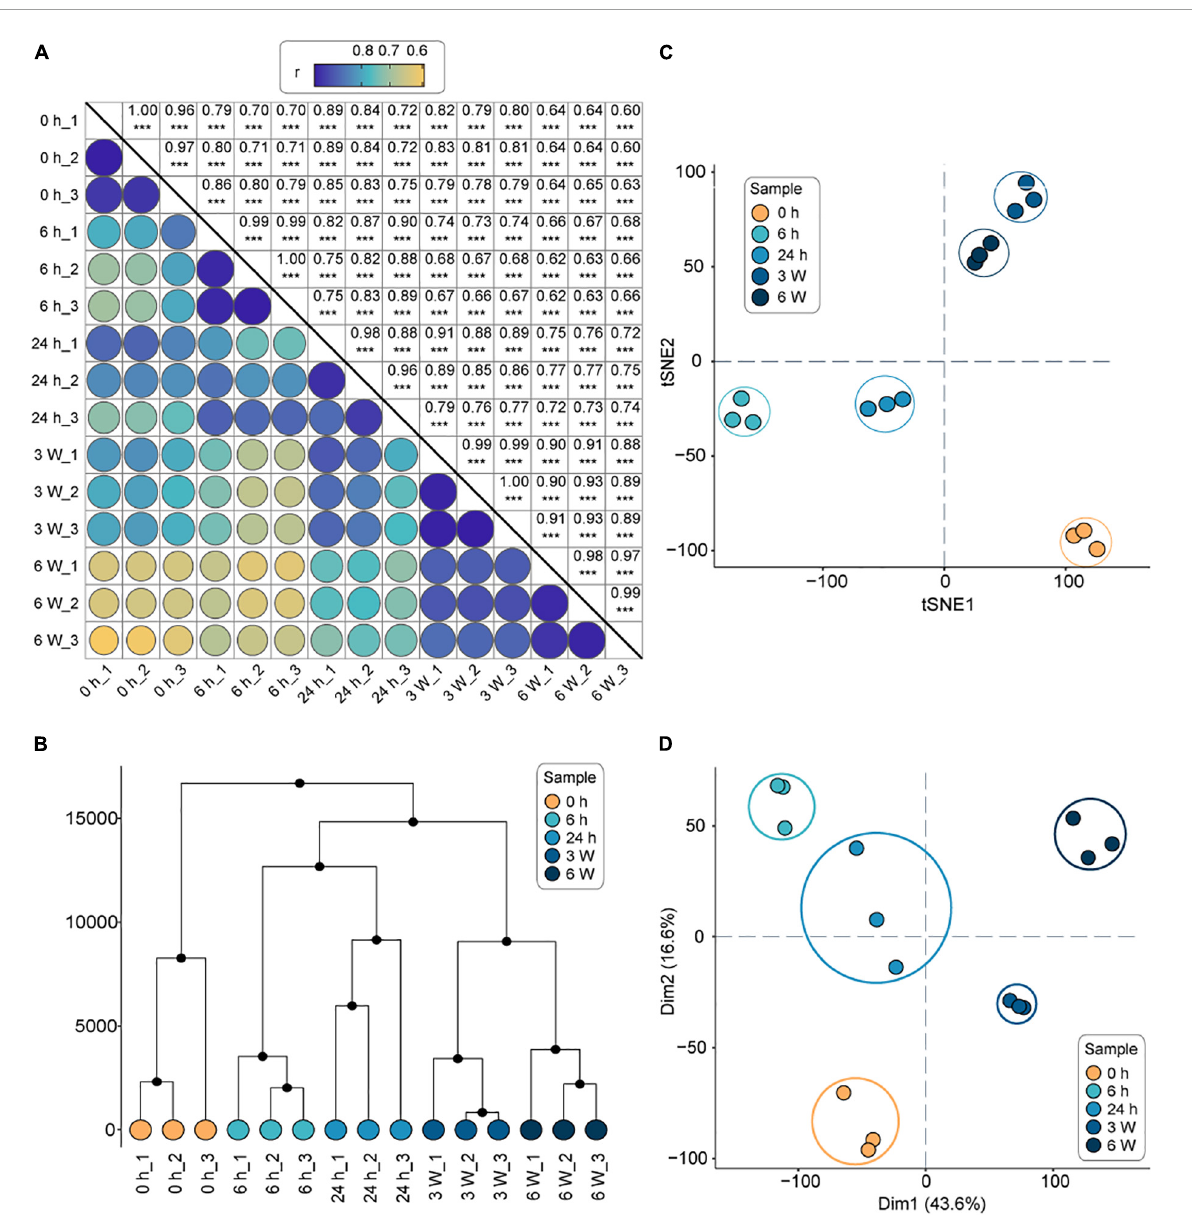
FIGURE1 The overall analysis of the transcriptomes of FRI-Col in different times of cold treatment. (A) Pearson’s correlation coefficient of gene expression values of all samples. ***, P < 0.001. (B) Hierarchical clustering analysis (HCA) of gene expression values of all samples. (C) t-Distributed Stochastic Neighbor Embedding (t-SNE) of gene expression values of all samples. (D) Principal component analysis (PCA) of gene expression values of all samples. Axes show principal components (PC) 1, PC2 which explained 60.2% of the variance. Each color represents one time point and three biological replicates were performed for each time point in separate experiments (15 samples in total) in (A–D)